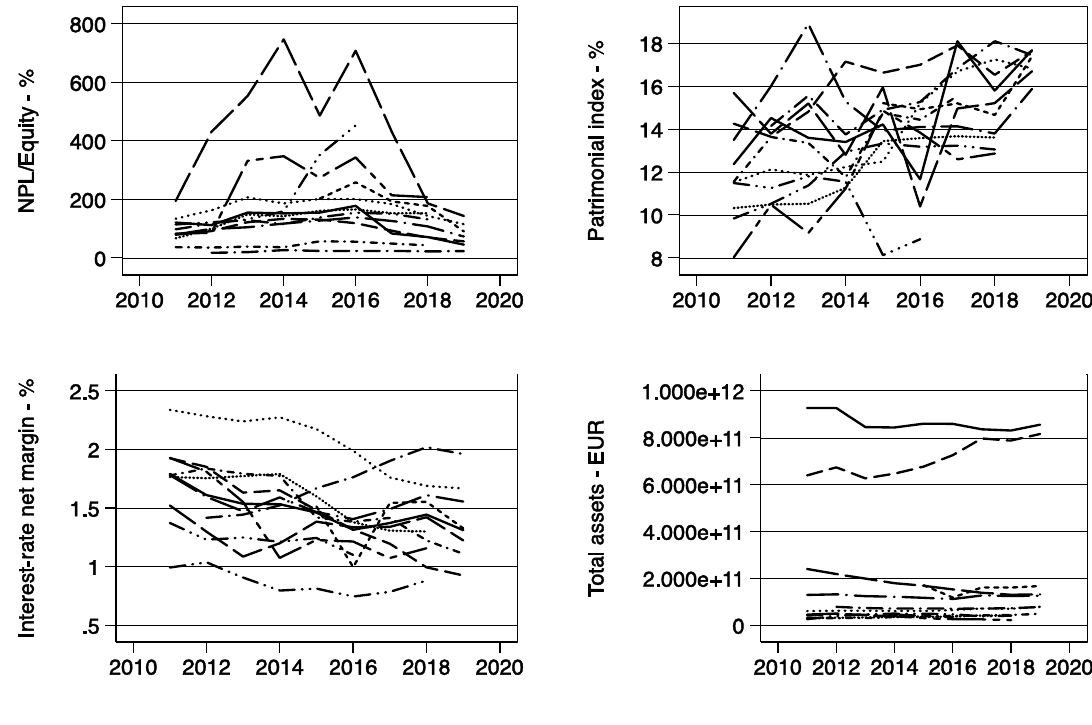
Figure A3. Dynamics of regressors